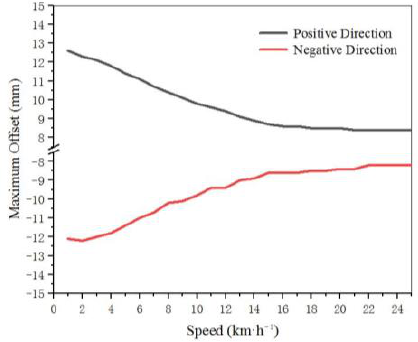
Figure 6. Simulation experiment of a gravity offset.